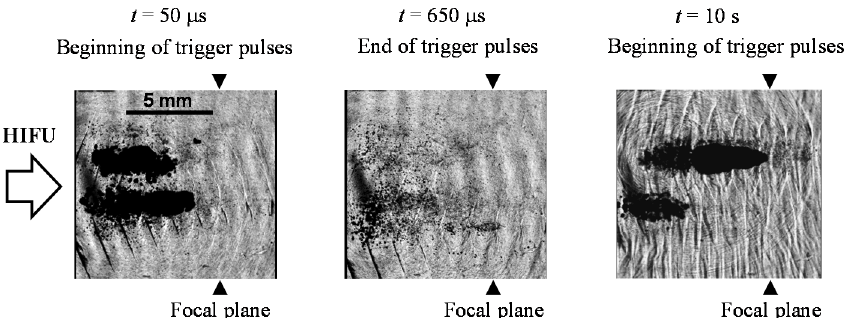
Figure 7. High-speed images of generated and sustained cavitation bubbles in a PAA gel including 15% BSA by a sequence of spot scanning trigger pulses followed by spot scanning heating bursts which is similar to that shown in Figure 1b [34]. The instantaneous total acoustic powers of the trigger pulses and heating bursts were 1900 and 65 W, respectively. The intentional focal plane shift of the trigger pulses was not applied in this case. The same camera and light source were used as in Figure 5, except for the optical magnification.